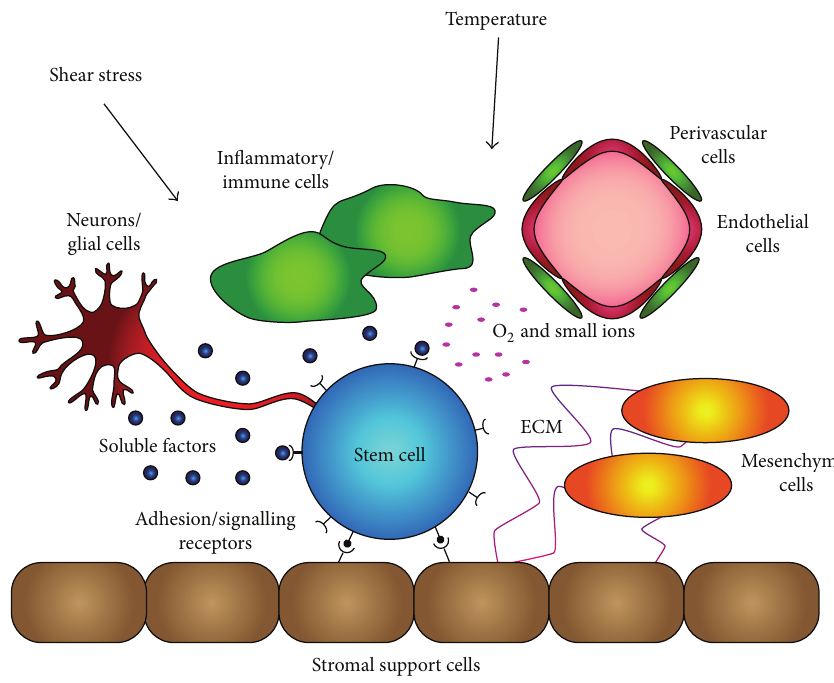
Figure 4: Stem cell niche. The stem cell niche is composed of multiple niche support cells, such as stromal and mesenchymal cells, that provide stimulus to a small subpopulation of stem cells. The stem cells are responsive to cellular and acellular regulatory components within the niche. These regulatory components control the fate of the stem cells, be it proliferation, self-renewal, differentiation, fate, programmed cell death, retention, or